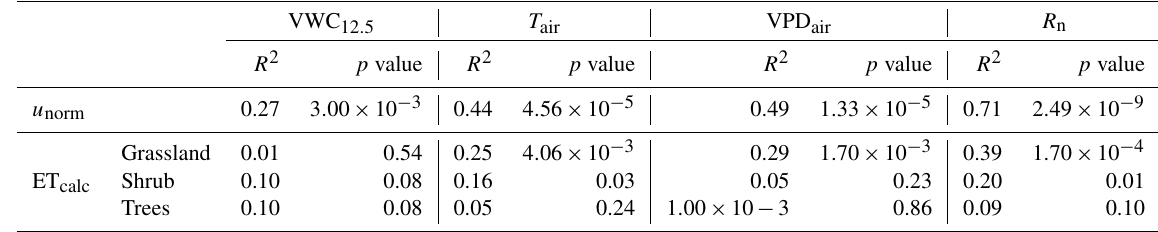
Table 5. R 2 and p values of the parameters used for the correlation plots of u norm and ET calc (Fig. 3).